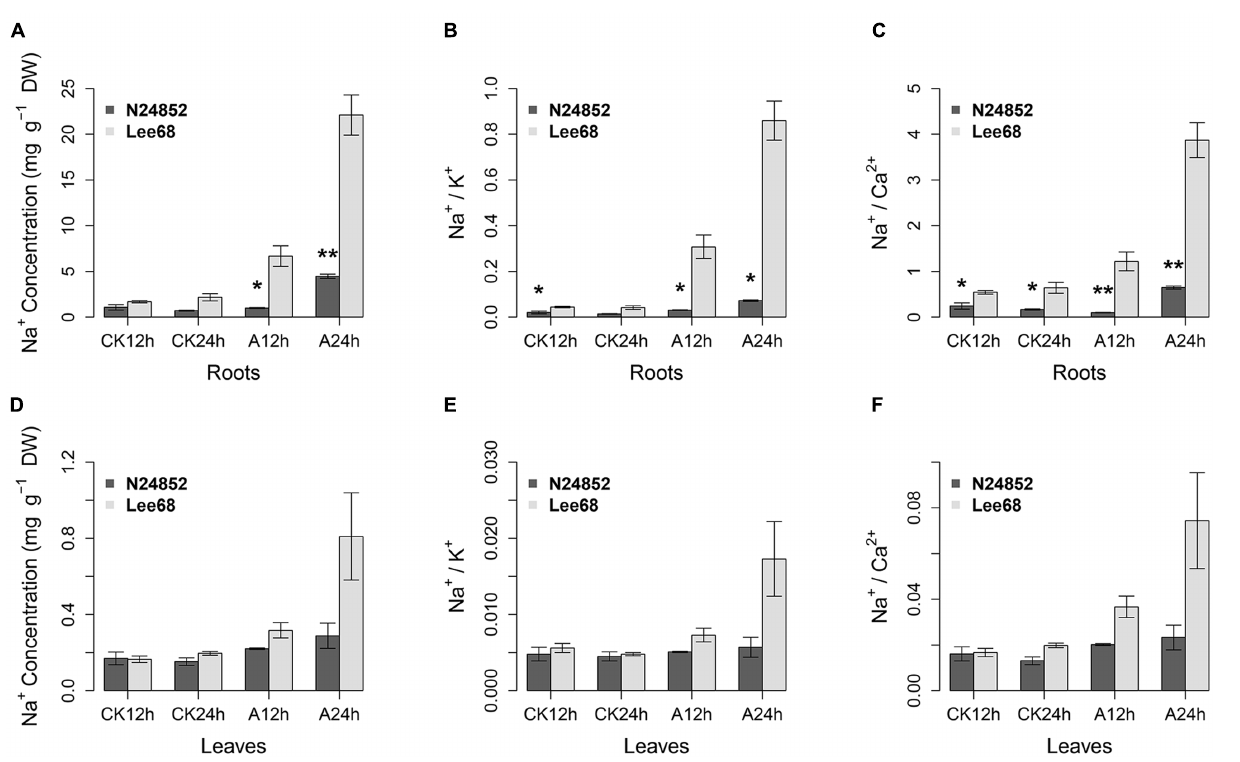
FIGURE 1 | Ion concentrations and ratios in N24852 and Lee 68 under control (CK) and alkaline stress for 12 and 24 h. (A) Na + concentration in roots, (B) Na + /K + ratio in roots, (C) Na + /Ca 2 + ratio in roots. (D) Na + concentration in leaves, (E) Na + /K + ratio in leaves, (F) Na + /Ca 2 + ratio in leaves. Alkaline stress was 90 mM NaHCO 3 (pH = 8.5) treatment, and control was 0 mM NaHCO 3 (pH = 6.5). ∗ and ∗∗ indicate significant difference at 0.05 and 0.01 level by student’s t -tests between two soybean genotypes, respectively. DW, dry